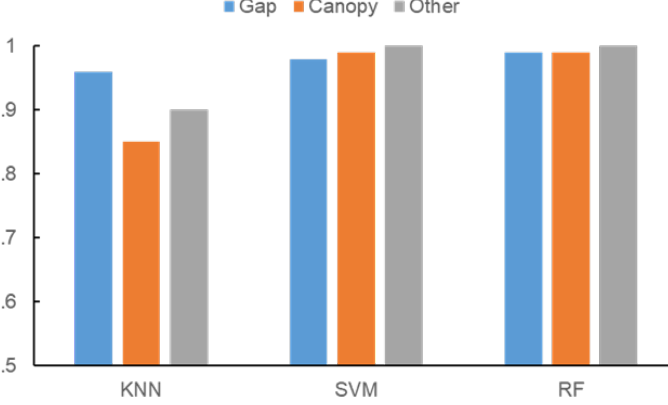
Figure 6. F1-Score of different categories under different classifiers in study area I. Table 3. The classification accuracies using edge information of study area I. Including the pro- ducer’s accuracy (PA), u ser’s accuracy (UA), and overall accuracy (OA) as well as the Kappa coeffi- cient.